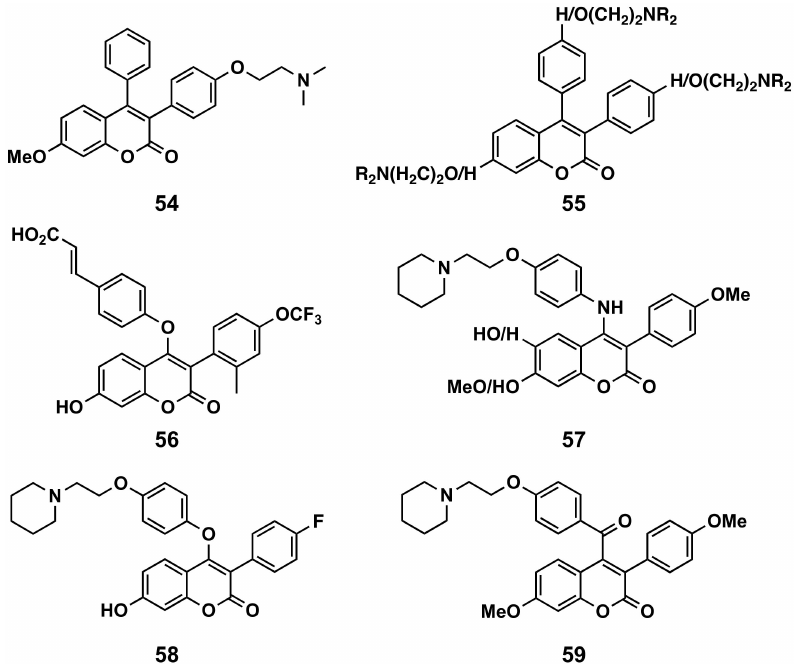
Figure 20. 3-Phenylcoumarins as anticancer agents: coumarins with a benzene ring bound directly or not to position 4 of the